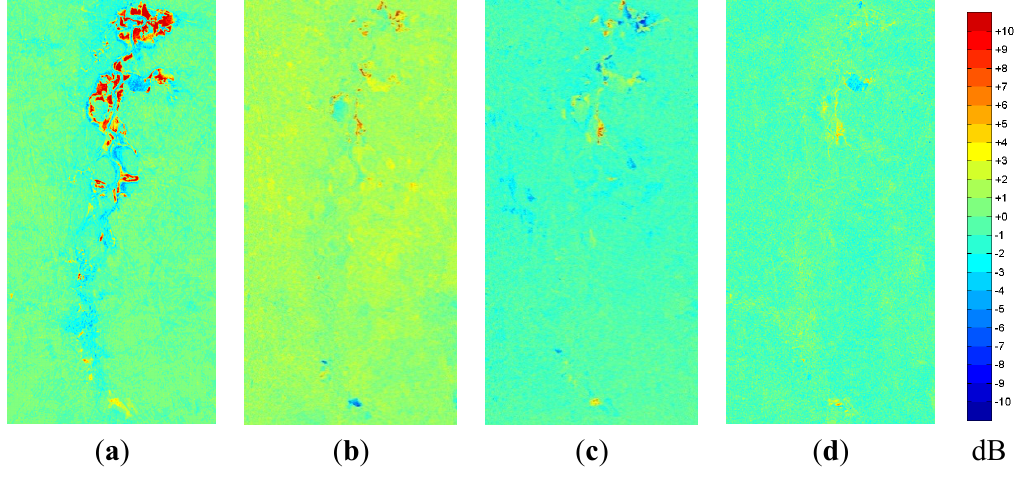
(total intensity) between sequent 0